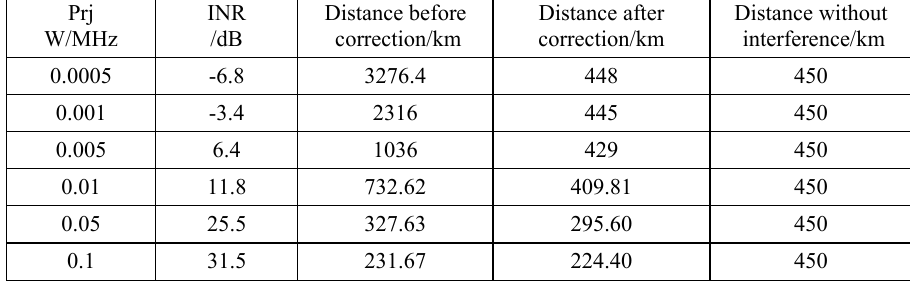
Table 4. Comparison of the radar main lobe self-defence distance after taking anti-jamming measures.